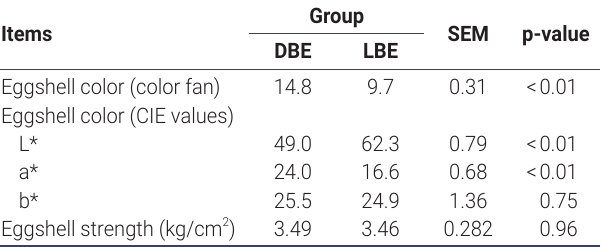
Table 1. Eggshell color and strength in laying hens with either dark brown eggshells or light brown eggshells Items